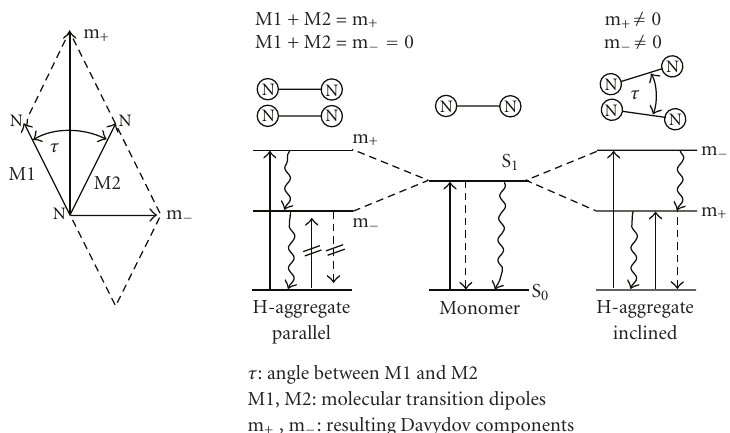
Scheme 1: Left: scheme of Davydov splitting; Right: model of molecule orientation and transition dipole interactions in dye H-aggregates and their absorption and fluorescence properties. The dumbbells model the dye molecules, solid arrows mark the absorption, broken arrows the fluorescence and wavy arrows the internal conversion, crossed lines are forbidden transitions.